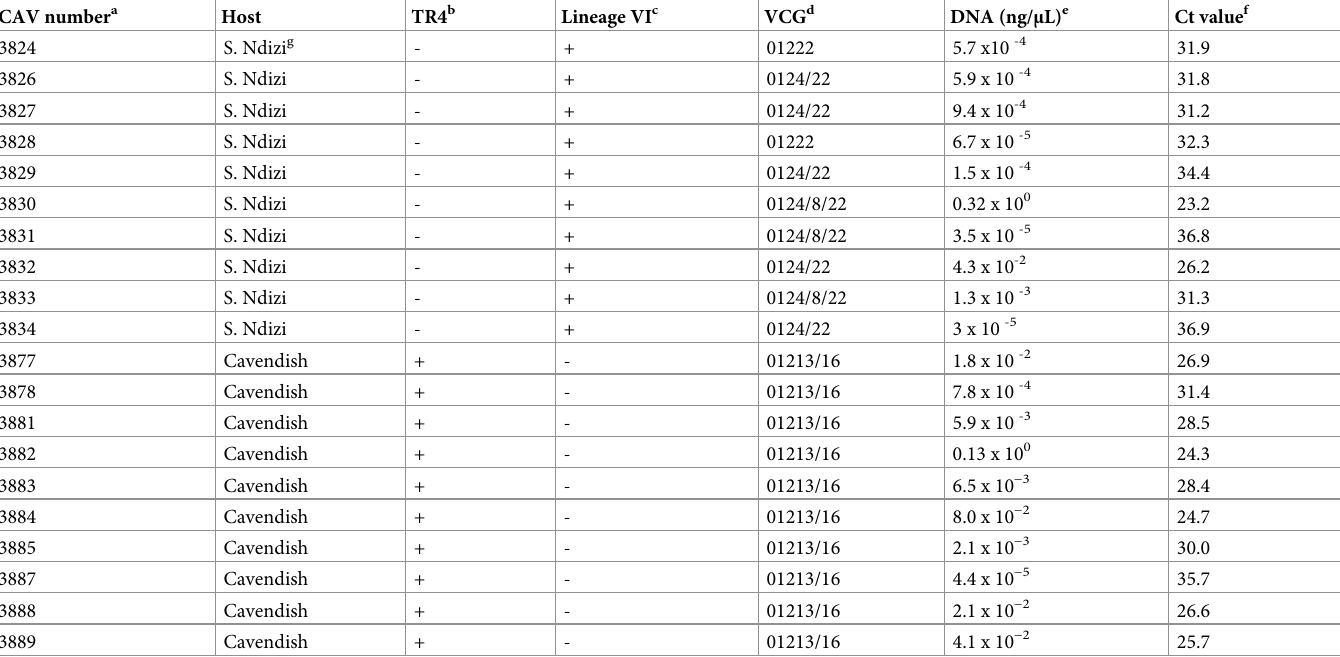
Table 5. Quantitative detection of Fusarium oxysporum f. sp. cubense (Foc) tropical race 4 (TR4) and Foc Lineage VI from naturally infected banana material. CAV number a